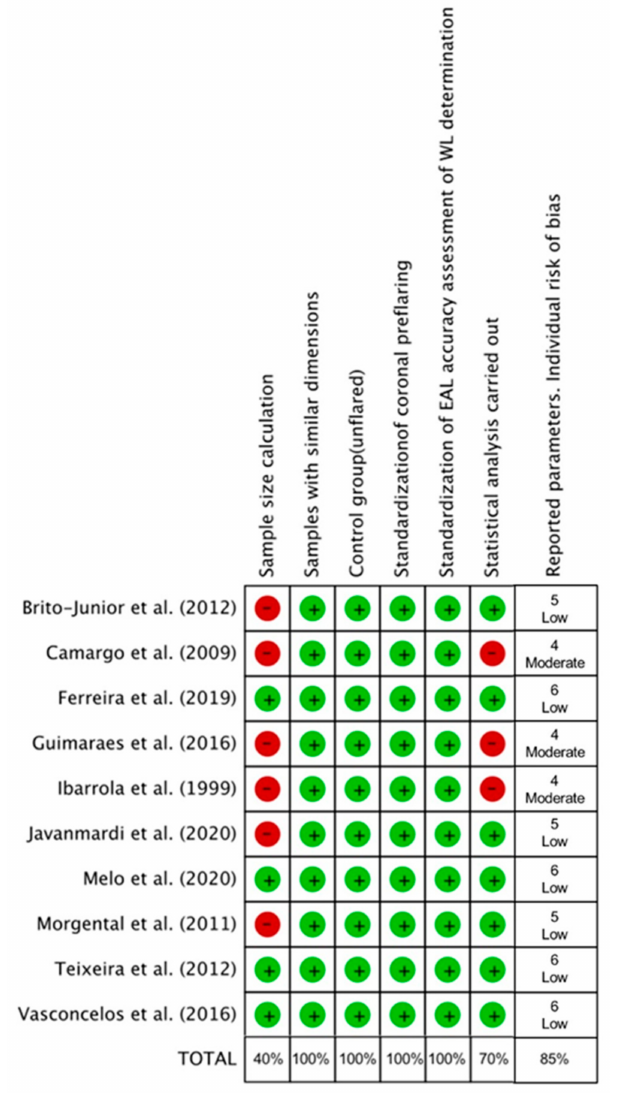
Figure 6. Quality assessment of included studies according to SYRCLE’s risk of bias tool [14], a RoB tool for animal intervention studies based on the Cochrane Collaboration RoB Tool